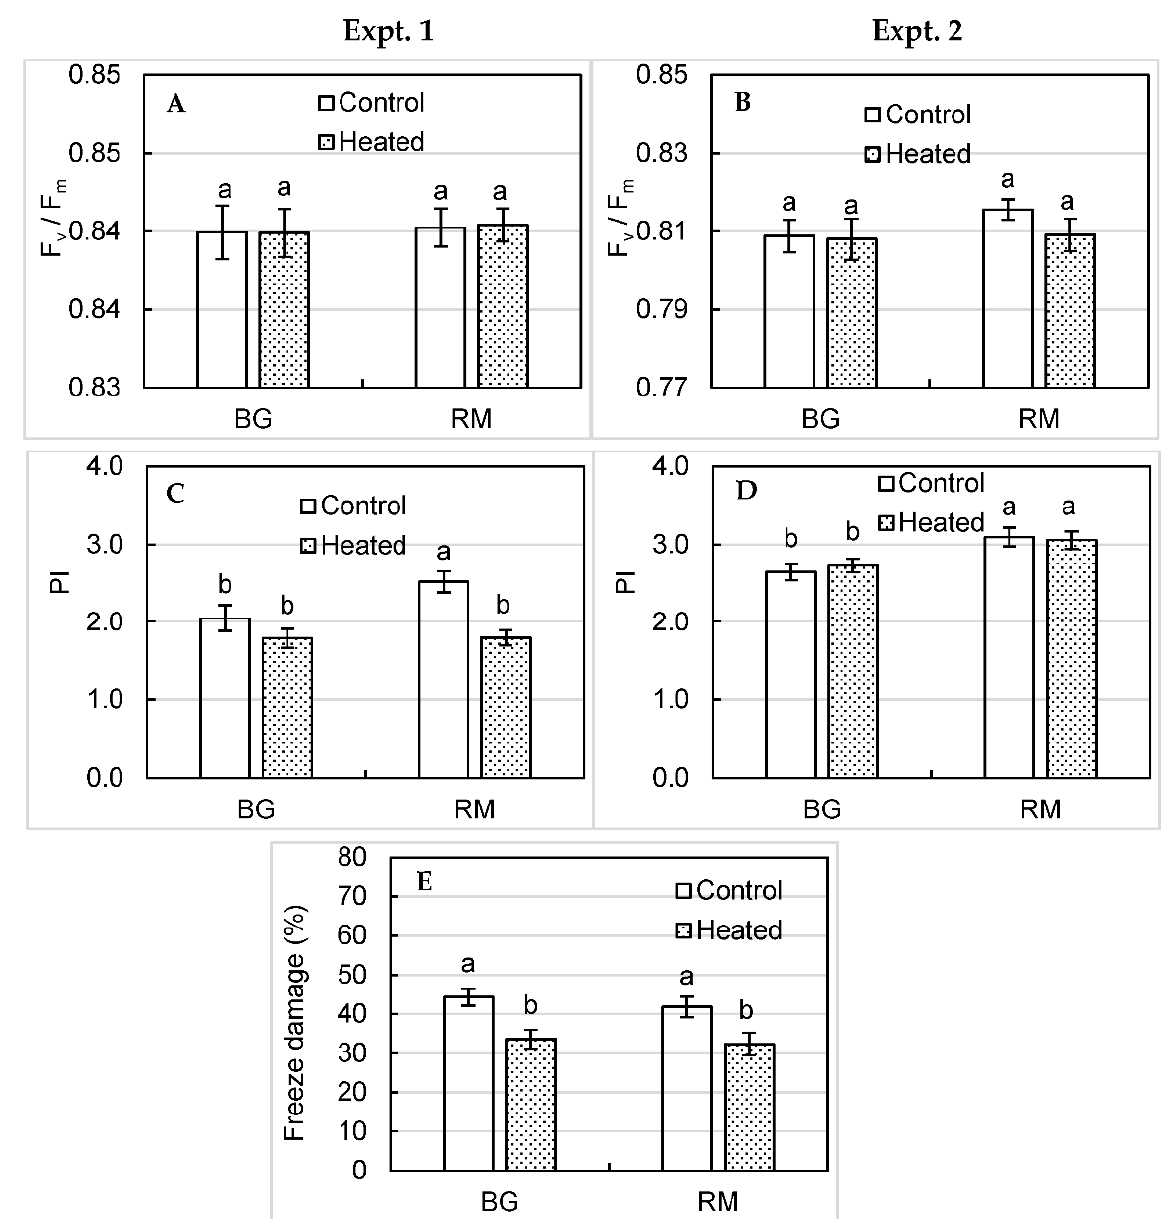
Figure 6. Chlorophyll fluorescence (F v /F m ) ( A , B ), and performance index (PI) ( C , D ) and plant freeze damages ( E ) of the lettuce varieties ‘Bergam’s Green’ (BG) and ‘Red Mist’ (RM) grown in a deep-water culture hydroponic system with nutrient solution heating or no heating (control). Different letters represent significant differences between treatments according to Tukey’s HSD test ( p < 0.05). The plant damage was caused by freezing air temperatures that occurred for several hours at night due to a power outage during the winter storm on Feb. 16, 2021 (DAT 18). Plants were visually assessed for freeze damage on the leaves a few days after the freeze event.